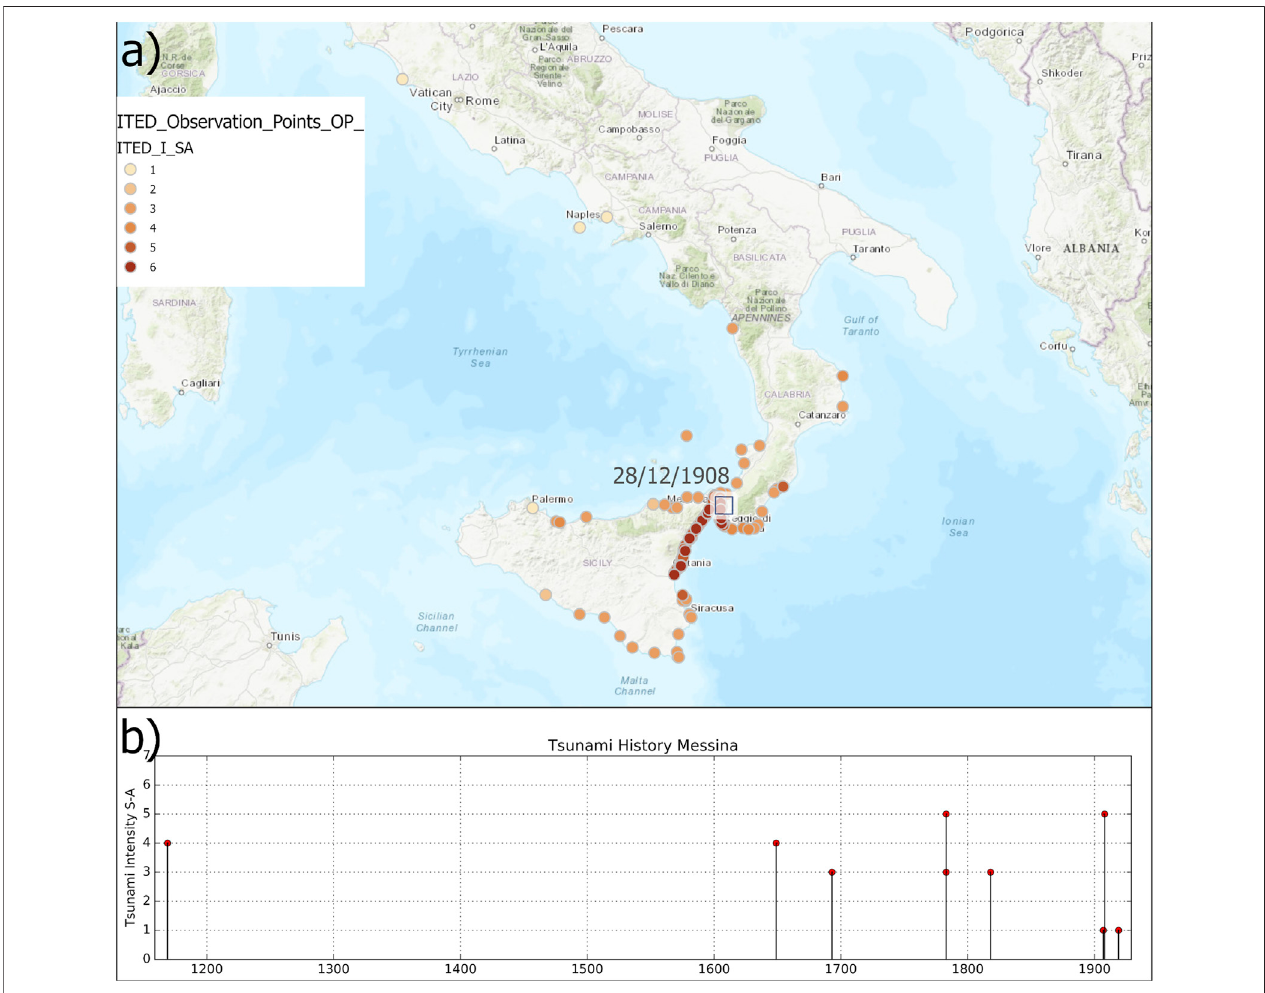
FIGURE 2 | (A) Snapshot of the OPs where the 1908 tsunami was observed, OPs symbols are colored according to the local tsunami intensity (Service Layer Credits: sources:©Esri, HERE,Garmin,Intermap,incrementPCorp.,GEBCO,USGS, FAO,NOAA,NPS,NRCAN,GeoBase, IGN,KadasterNL,OrdnanceSurvey,Esri Japan,METI,NASA,EsriChina(HongKong),©swisstopo,©OpenStreetMapcontributors2019.DistributedunderaCreativeCommonsBY-SALicense). (B) Exampleof tsunami history contained in ITED: Messina.